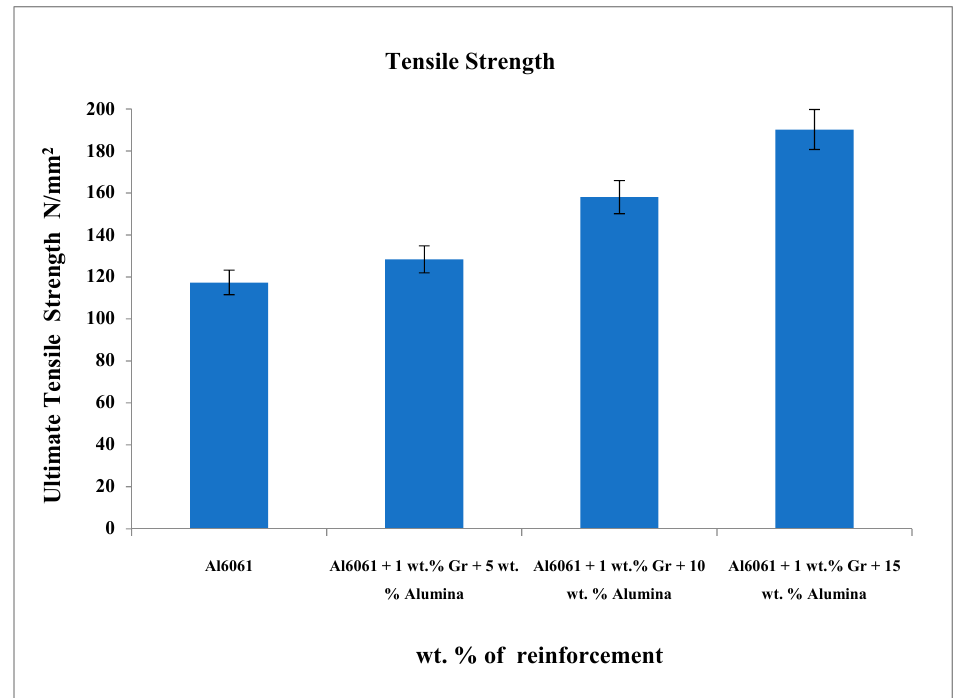
Figure 3. UTS variation in hybrid Al6061-Al 2 O 3 -Graphene composites .